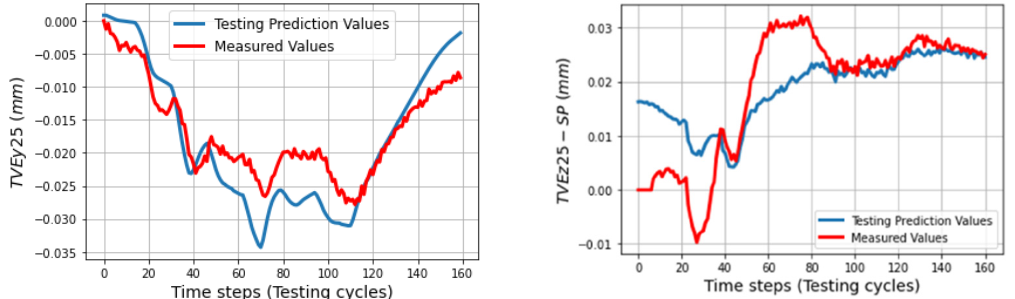
Figure 19. Prediction of TVEy25 and TVEz25 in the short process (SP) (1 cycle = 15 min). The Root Mean Square Errors (RMSEs) and fi tt ings of predictions compared with measured values are calculated by Equations (6) and (7) and are shown from Figures 20– 24.